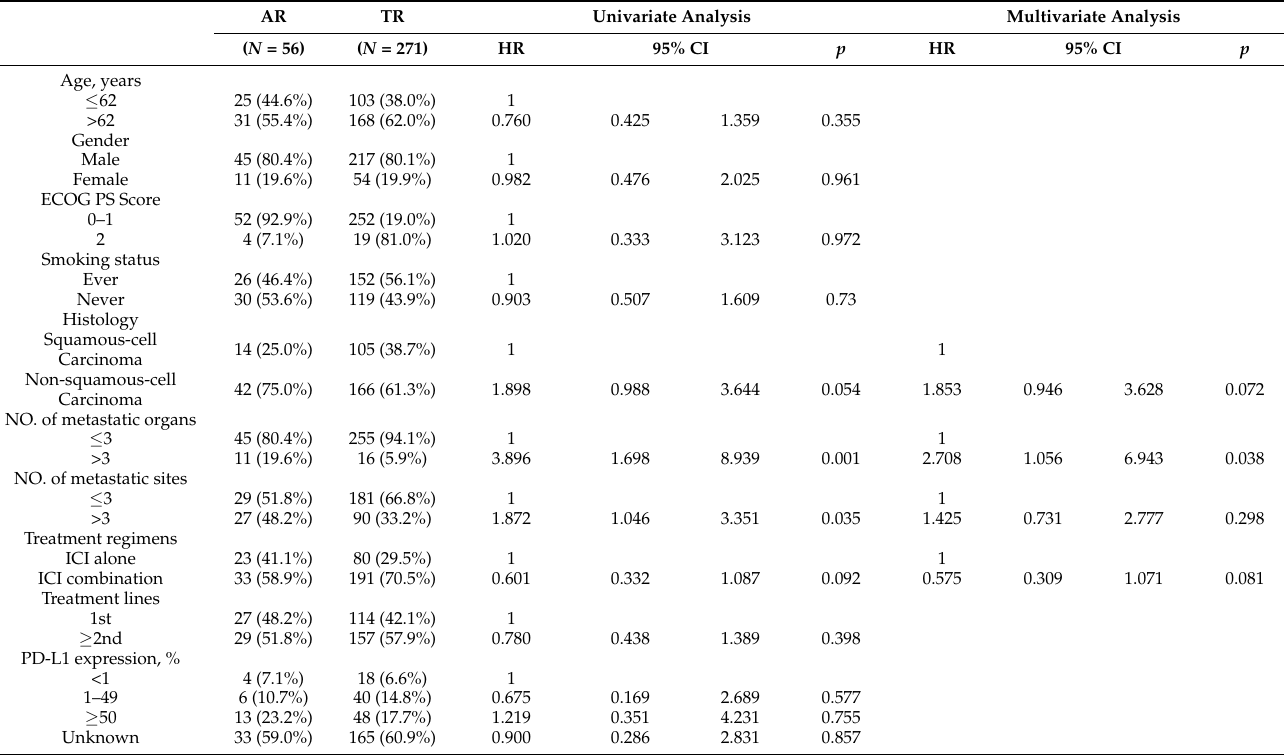
Figure 1. Flowchart of patient enrollment. Table 1. Baseline characteristics and logistic regression analysis for predictors of atypical response.